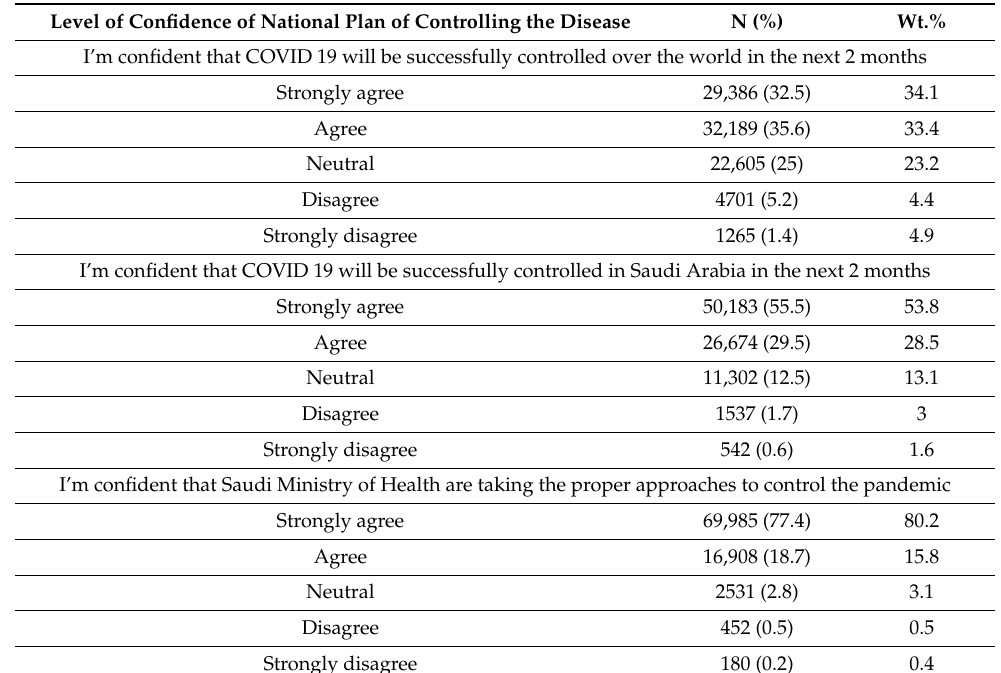
Table 6. Trust in the governmental authorities’ mitigation